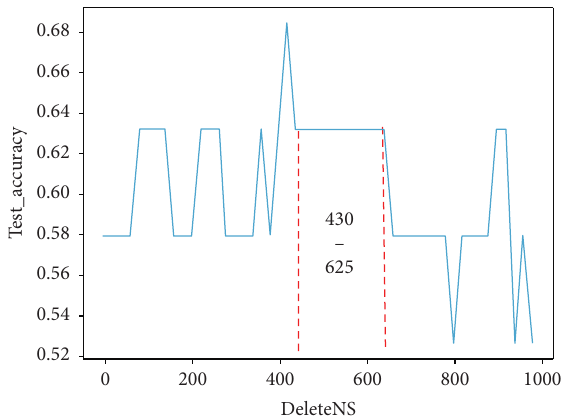
Figure 3: Curve 3 of deleteNS and classification accuracy.